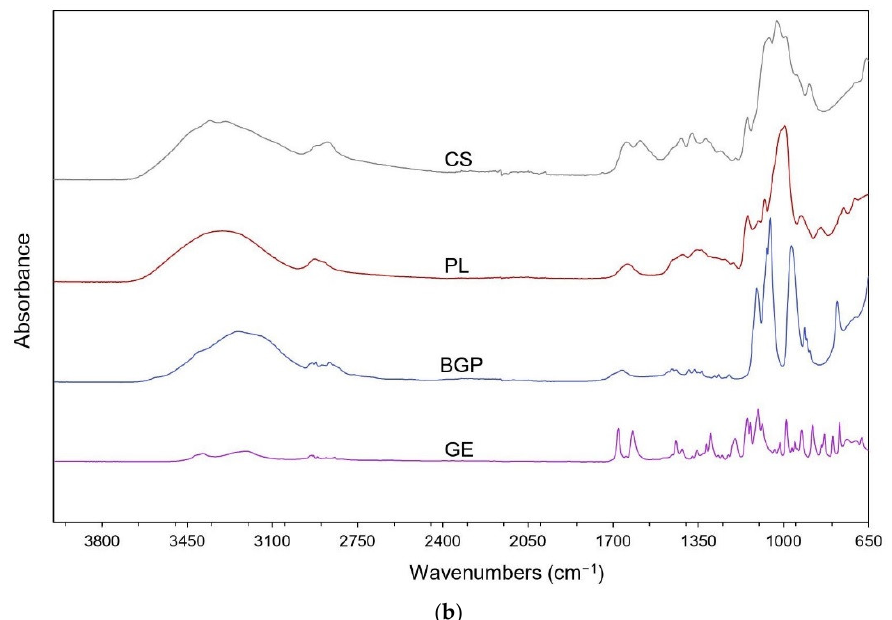
Figure 3. Attenuated total reflectance-Fourier-transform infrared (ATR-FTIR) spectra of CS/PL-based hydrogels ( a ) and raw materials ( b ).